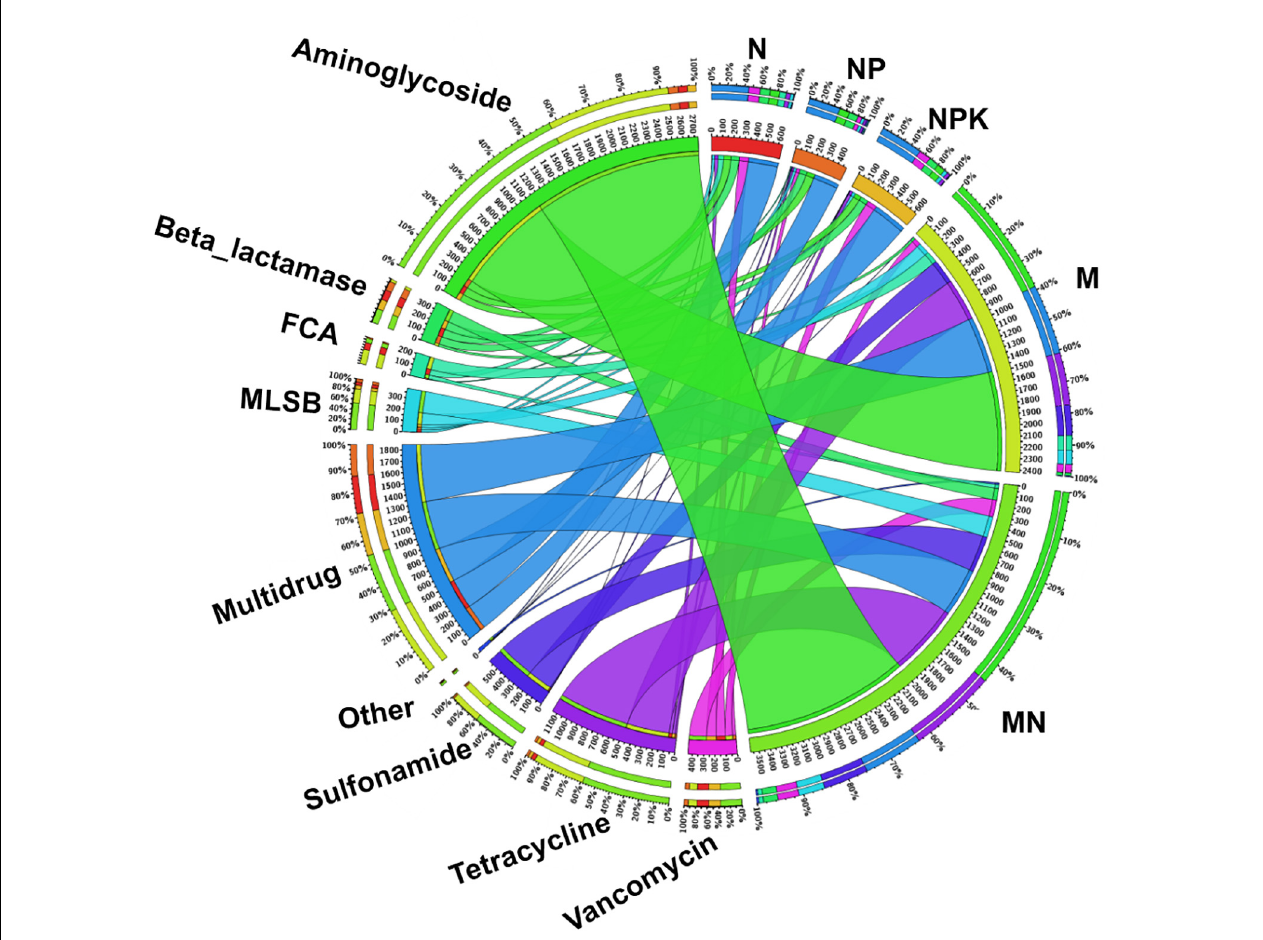
FIGURE 4 | The distribution of each ARG subtype in fertilized soils determined using Circos software (http://circos.ca/). Numbers on the inner ring represent the total fold change of each fertilization treatment. Numbers on the outer ring represent the percentages of ARG subtypes in each fertilization treatment. FCA, fluoroquinolone, quinolone, florfenicol, chloramphenicol, and amphenicol; MLSB, macrolide-lincosamide-streptogramin